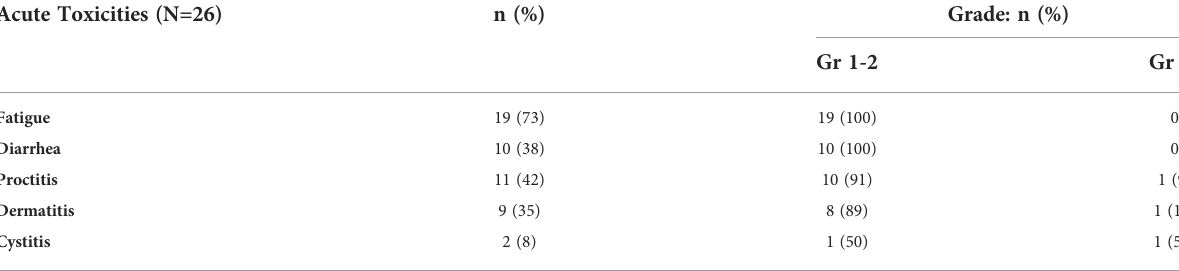
TABLE 3 Acute toxicities associated with anorectal radiation therapy (RT) after prior prostate RT. Acute Toxicities (N=26)